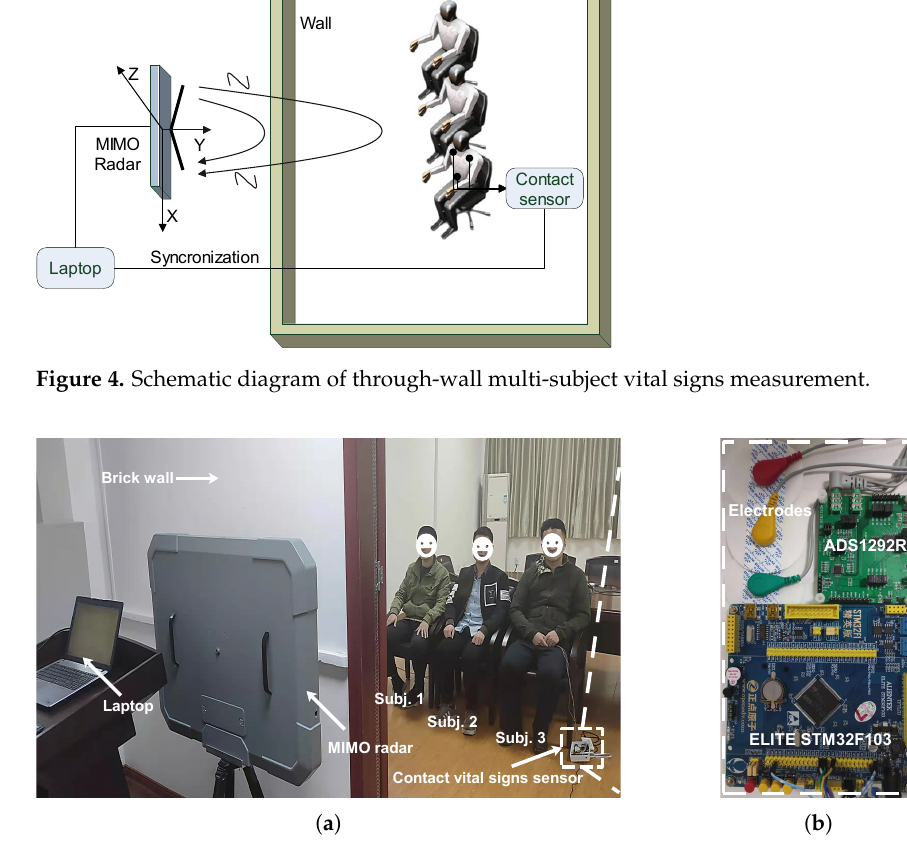
Figure 5. ( a ) Experiment scenario of through-wall vital signs detection. ( b ) Photograph of the contact vital signs